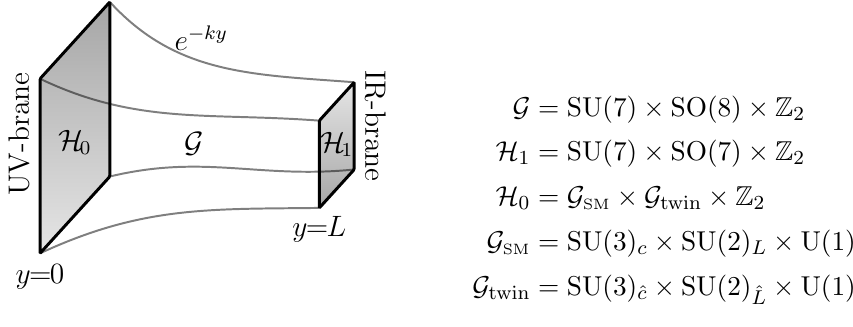
Figure 1 . A pictorial depiction of holographic twin Higgs which employs (cid:12)ve dimensional RS geometry with a bulk gauge symmetry brane to H 1